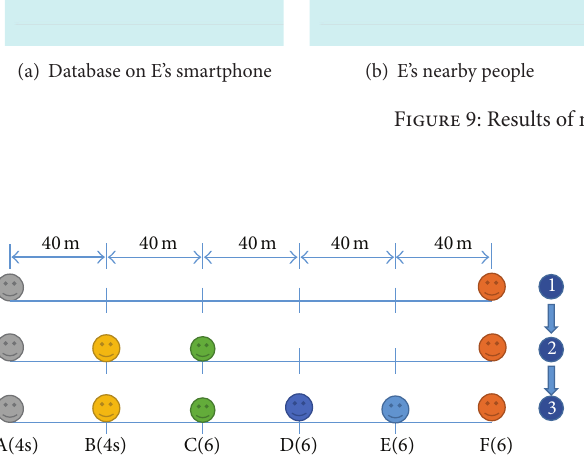
Figure 10: Dense node experiment